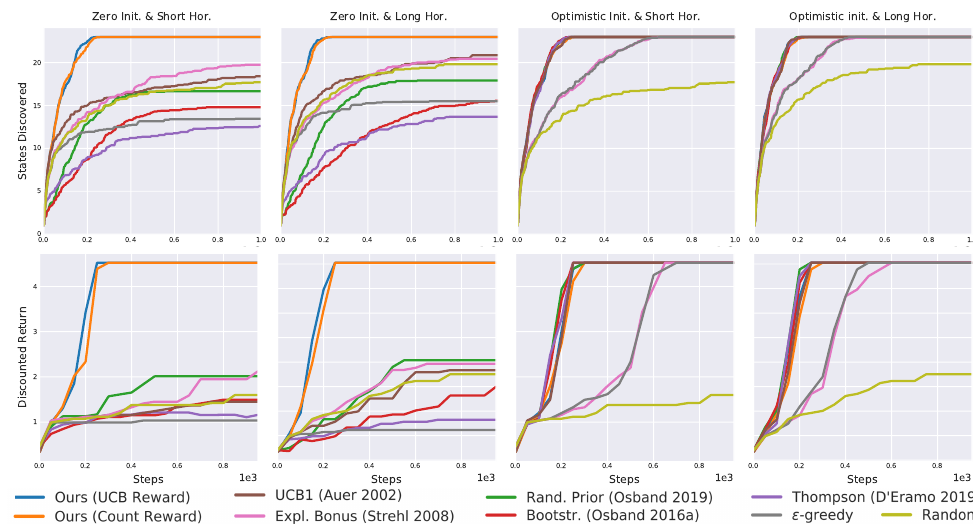
Figure 17. The “prison” and distractors affect the performance of all algorithms but ours.